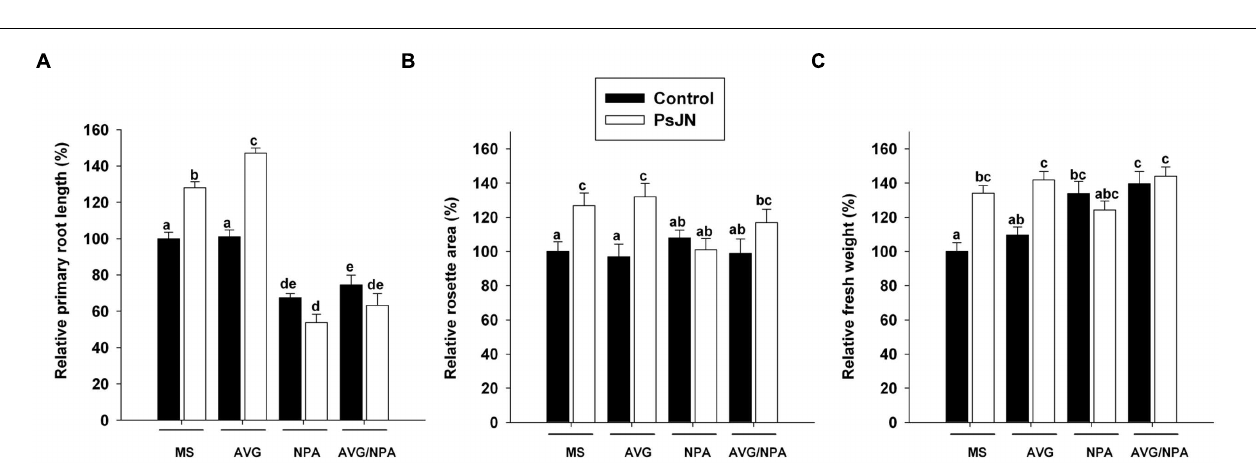
FIGURE 3 | Temporal quantitative real-time PCR of selected Arabidopsis genes related to ethylene biosynthesis after inoculation with B. phytofirmans PsJN. Relative gene expression of selected genes involved in the ethylene biosynthesis pathway in roots and shoots at 2, 24, 48, and 96 hpi with the strain. Data are means ± SE of 3–5 biological replicates per treatment, each considering tissue from 5 to 13 plants and two technical replicates. Normalization was performed with the housekeeping SAND family gene (AT2G28390). Asterisk indicates statistical significance among treatments in a particular time (One way ANOVA, p < 0.05).